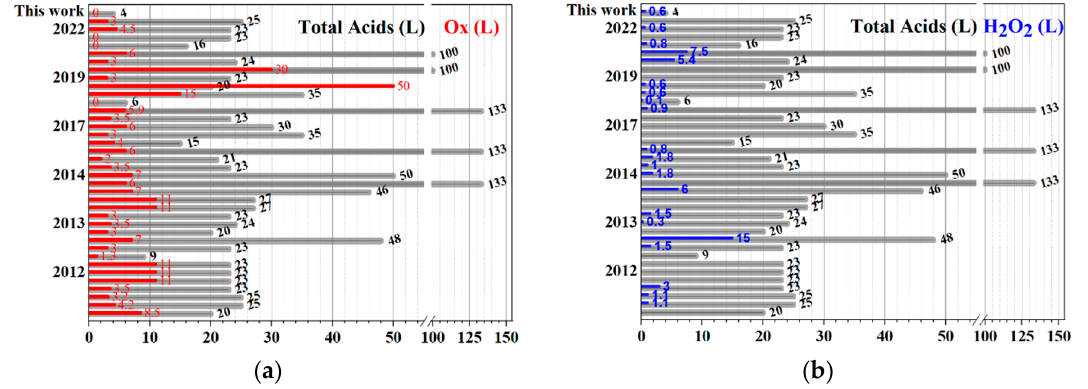
Figure 13. Comparative graph with values taken from Table 1, total oxidants ( a ) and hydrogen peroxide ( b ) used during the product synthesis.